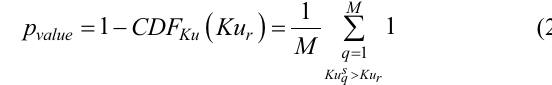
Bootstrap algorithm for estimation of p Kuiper test over fuzzy samples 1. Select the sample approximation of CDF using the